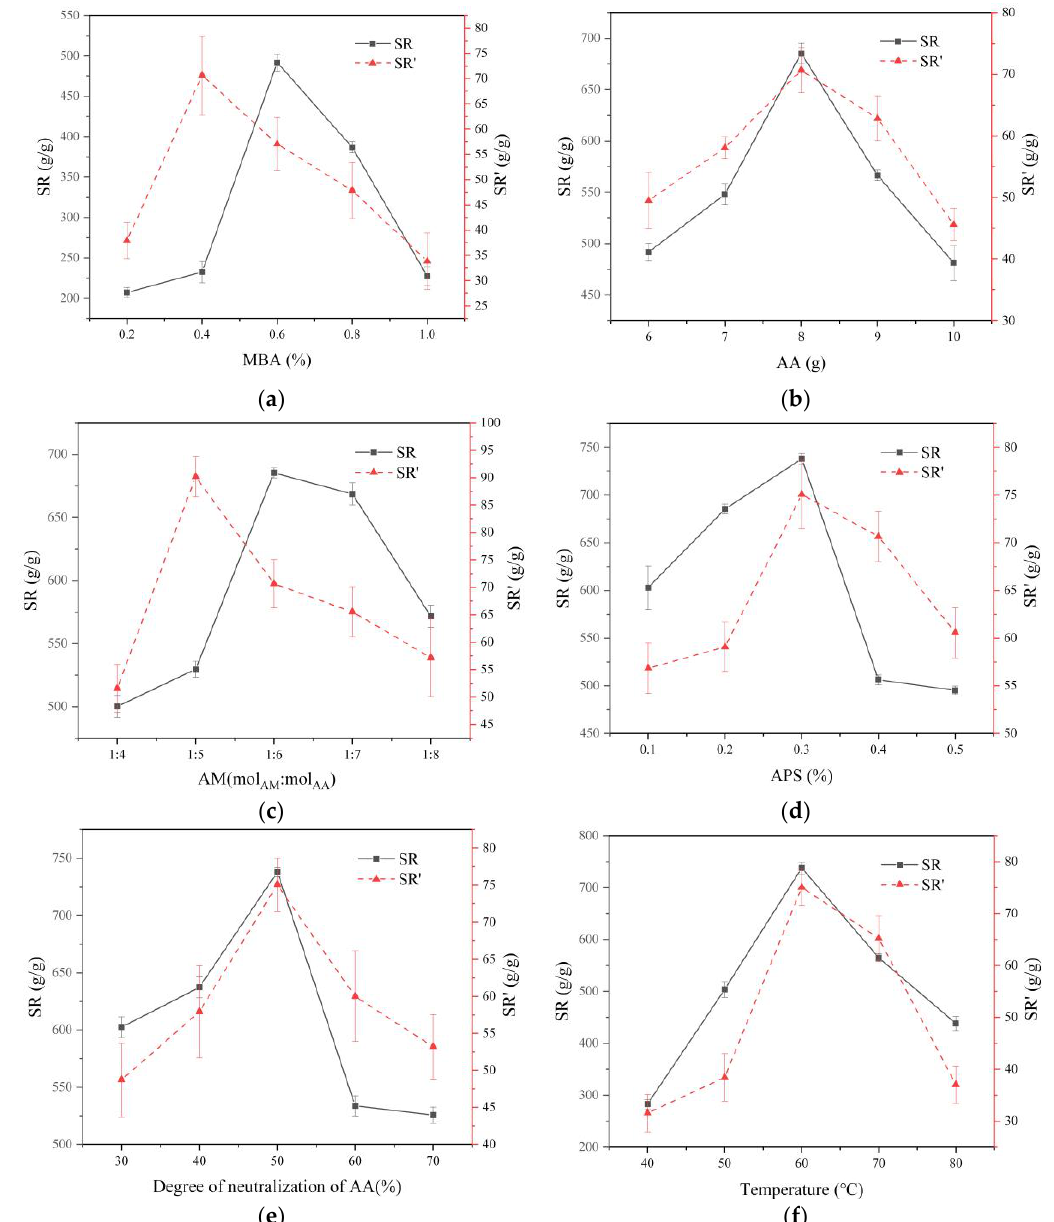
show a decreasing trend. When the content of the crosslinker is too high, the voids in the network structure of the polymer would shrink, so that the swelling property of the polymer is inhibited.